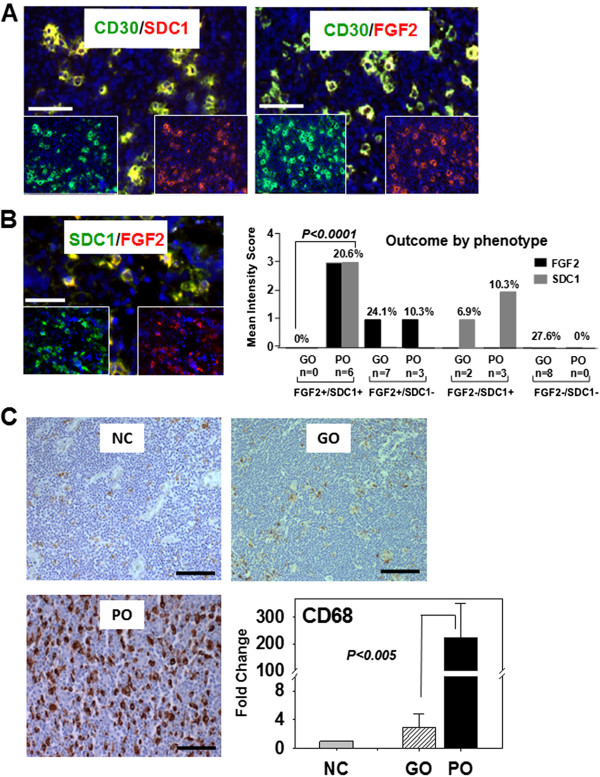
CD30+ cells coexpress FGF2 and SDC1 in macrophage-rich HL tissues with poor outcome. (A) Double immunofluorescent staining showing expression of either FGF2 or SDC1 by CD30+ cells of poor outcome samples. Individual green or red fluorescence is depicted at the bottom of each image; scale bar (white solid bar) represents 100 μm. (B) Distribution of the immunophenotypes by outcome. The mean intensity scores for FGF2 (solid gray bar) and SDC1 (solid black bar) (y-axis) for the good outcome (GO) and poor outcome (PO) groups of HL patients. Immunofluorescence intensity was scored as 0 (no staining), 1 (weak), 2 (moderate), or 3 (strong) for FGF2+ or FGF2- and SDC1+ or SDC1-. The frequency (%) of expression of each combination of FGF2+/− and SDC1+/− among all tissue sections is indicated above each bar. (C) CD68 macrophage marker expression was analyzed by immunostaining (image) and qRT-PCR (graph) in normal lymph node control (NC), good outcome (GO), and poor outcome (PO) groups of HL patients. The fold-change in CD68 mRNA was calculated after normalization with NC. Significance of all qRT-PCR data comparing GO and PO is indicated for (B) and (C) (p < 0.005). Scale bars represent 100 μm.